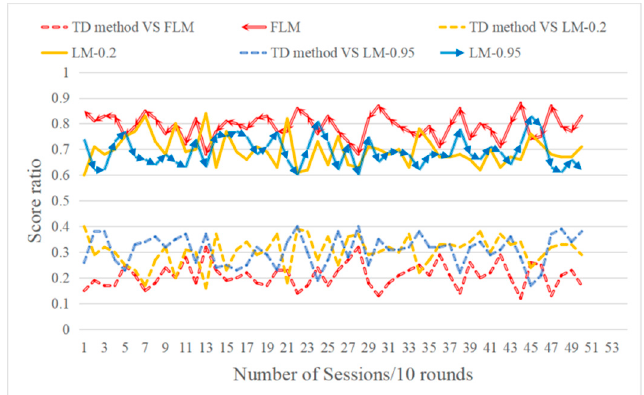
Figure 14. Comparison of learning results for different learning rates.